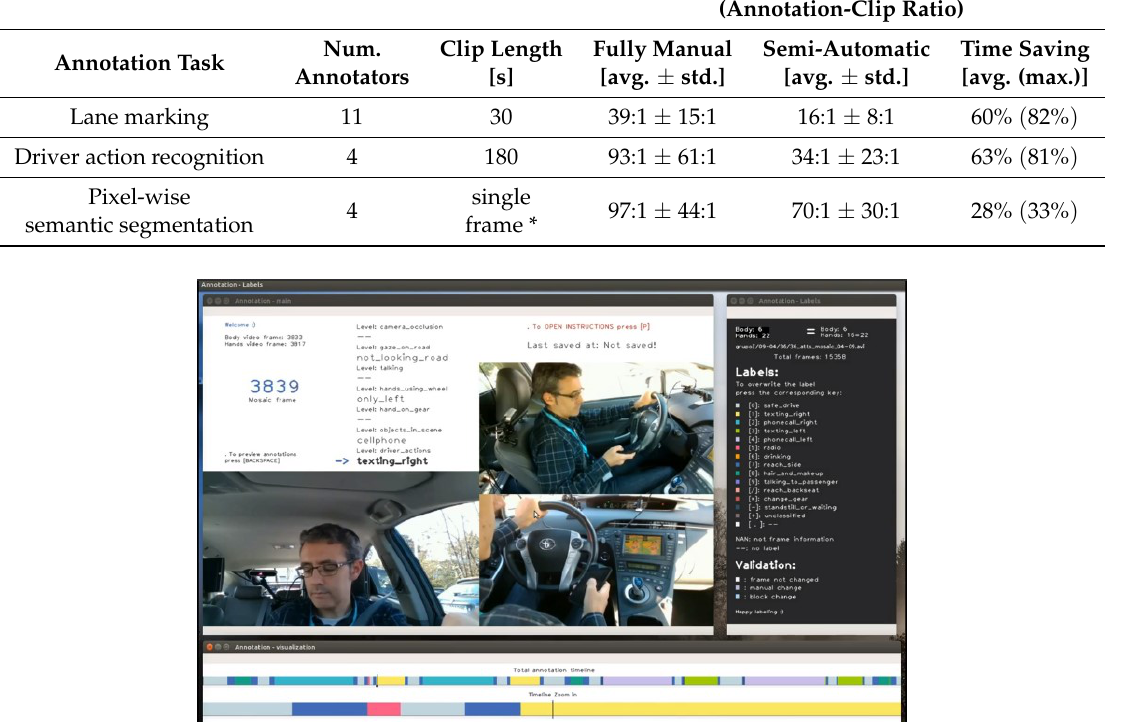
Figure 9. Manual annotation tool for driver action recognition (DMD (Driver Monitoring Dataset) dataset), which loads pre-annotation and allows human operators to review/modify